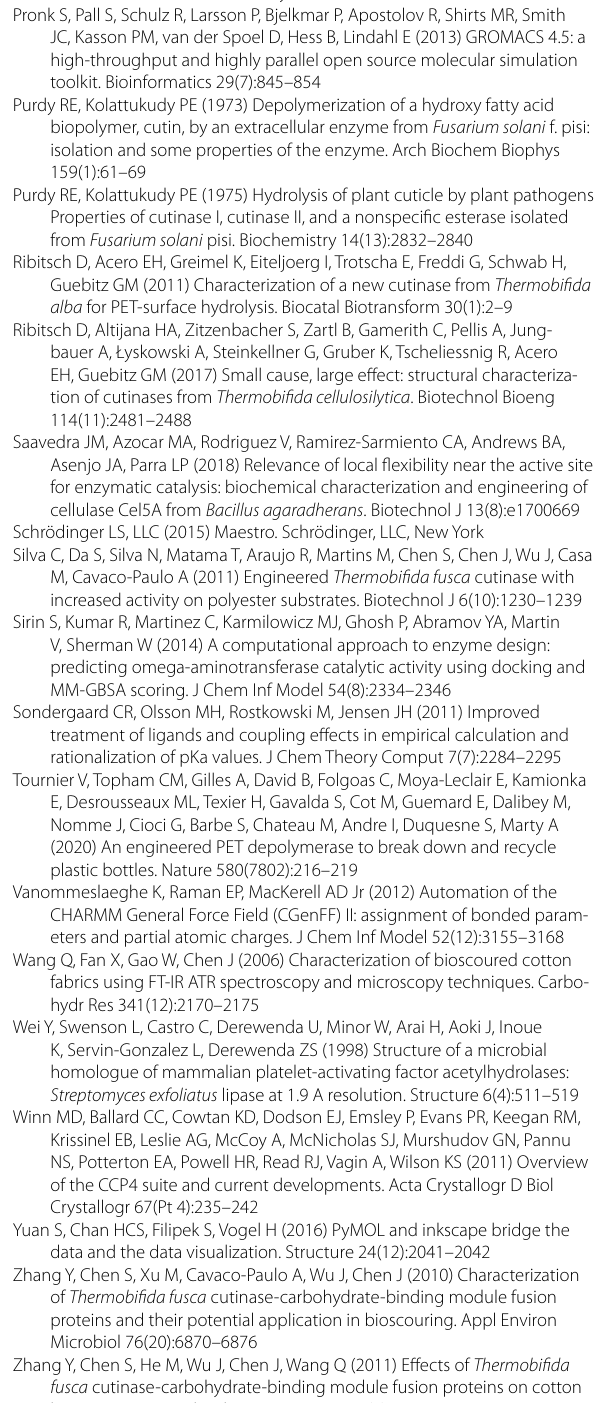
structure validation for macromolecular crystallography. Acta Crystallogr D Biol Crystallogr 66(Pt 1):12–21 Delano WL (2012) The PyMOL molecular graphics system, Version 1.50 Emsley P, Lohkamp B, Scott WG, Cowtan K (2010) Features and